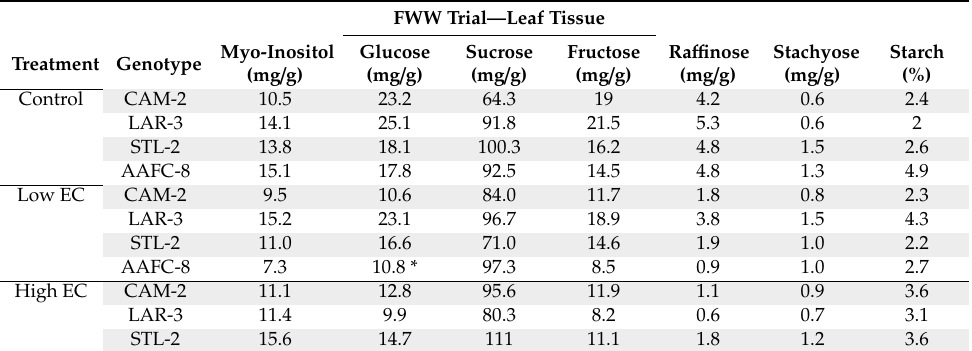
Table 5. Soluble sugar content of willow and hybrid willow leaf tissues at the conclusion of the FWW trial treated with control, low, and high fracking wastewater treatments ( n = 3 for genotypes and treatments). Asterisks indicate significant treatment e ff ect compared to control ( p < 0.05). AAFC-8 is omitted at the high fracking wastewater treatment due to limitations in available tissue.